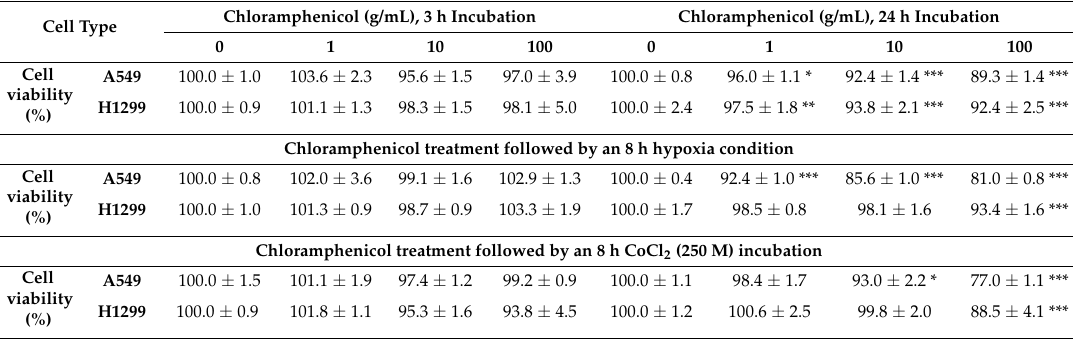
Table 1. Effects of chloramphenicol on non-small cell lung cancer cell